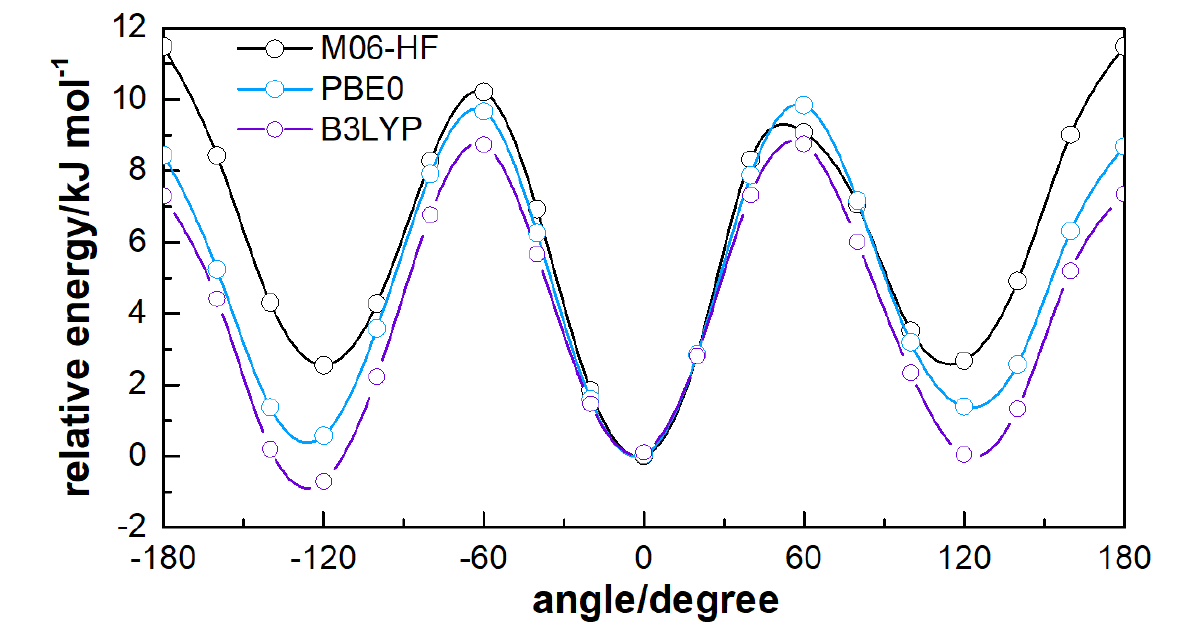
Figure 3. Partially optimised potential energy as a a function of the conformational angle φ 1 − 7 − 8 − 9 . The lines are spline-type for a better